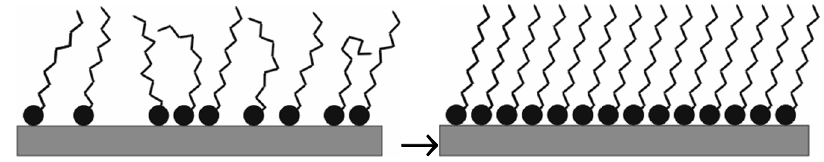
→ Figure 1. Schema of the time-dependent compact SAM layer formation (with courtesy of L. Románszki).